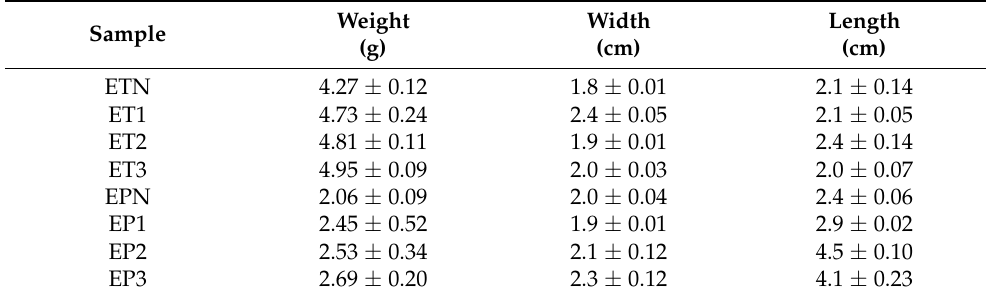
Table 2. Quantitative measures of sample appearances. Weight, external diameter and length